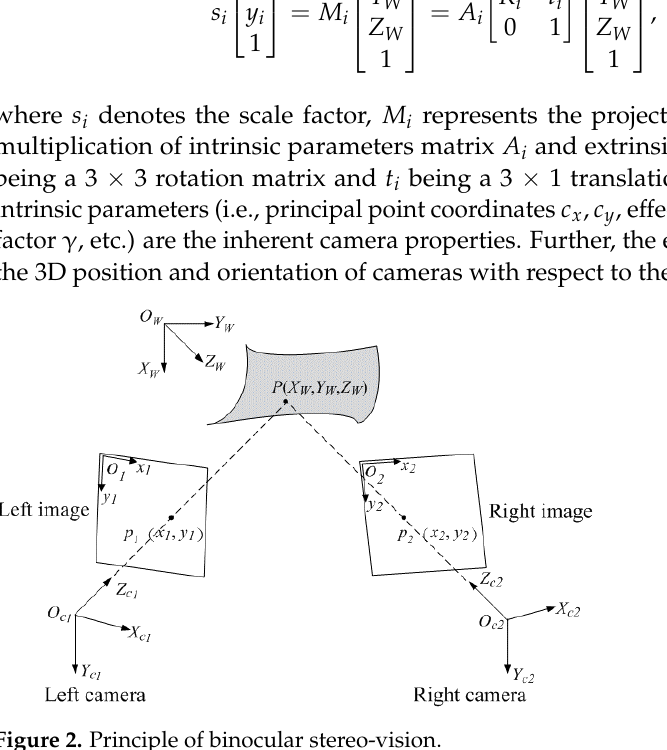
Figure 2. Principle of binocular stereo-vision.